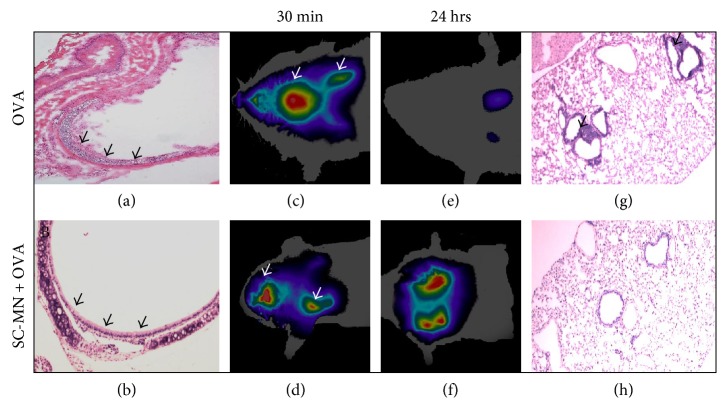
Effect of SC-MN on OVA-induced airway pathology in BALB/c mice. Upper panels: OVA-allergic BALB/c mouse. Lower panels: SC-MN-treated allergic BALB/c mouse (1 mg, i.n., 30 min prior to each OVA challenge). (a) H&E staining of the trachea shows epithelial denudation (arrow) compared to that of the intact epithelium in SC-MN-treated mouse (b). (c–f) FRI of mice 30 min (c, d) and 24 hrs (e, f) post i.n. administration of liposome. Notice the increase in central airway signals (arrow head) with less lung deposition (c) and faster clearance (arrow) (e) in untreated allergic mouse compared to the SC-MN-treated mouse (d, f). Images of the abdomen showed no signals in the stomach. Color intensity: red > yellow > green > blue. The FRI images are representative of 2 separate experiments with similar results. (g) Peribronchial cellular infiltration in H&E lung sections compared to the paucity of peribronchial cellular infiltration in SC-MN-treated mouse (h), representative of 3 separate experiments. Final magnification: 100x.